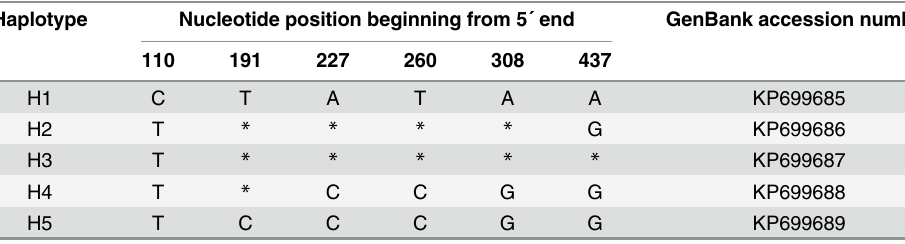
Table 5. Variable Position of 5 Haplotypes of ND1 in Macridiscus multifarius . Haplotype